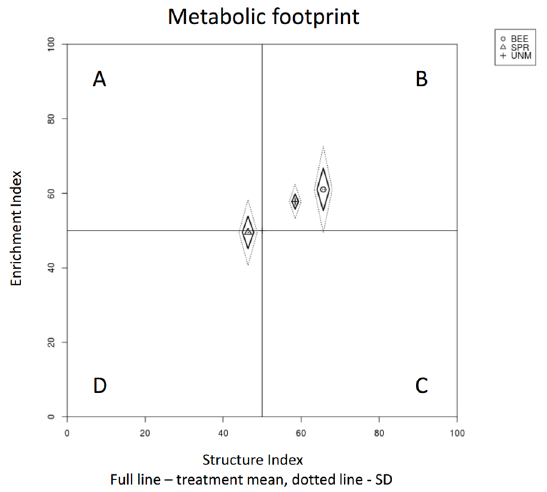
Figure 1. Functional metabolic footprint of nematodes in three forest types: BEE—European beech Fagus sylvatica L.; SPR—Norway spruce Picea abies (L.) H. Karst.; UNM—unmanaged old-growth forest, in 2019 in Po ľ ana Mts.